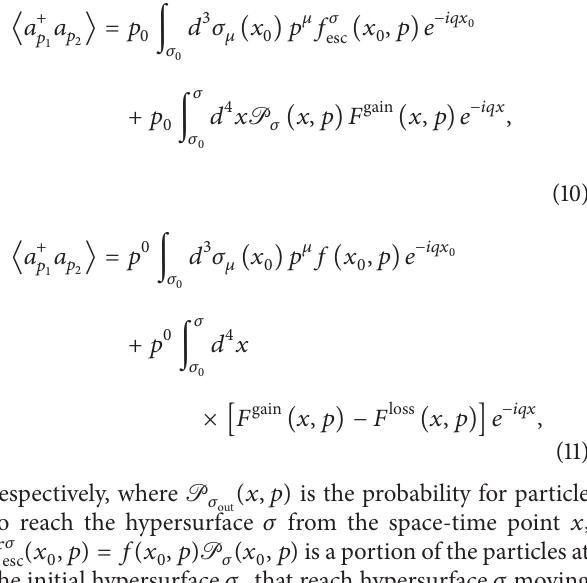
(𝑥 ,𝑝 ) ≈ 0 for 1 1 esc 𝜇 (𝑥 )𝑓 𝜎 (𝑥 , 𝑝) ≈ 1 1 0 esc , 𝑝) the similar value 1 Δ𝜎 1 it is negative if 0